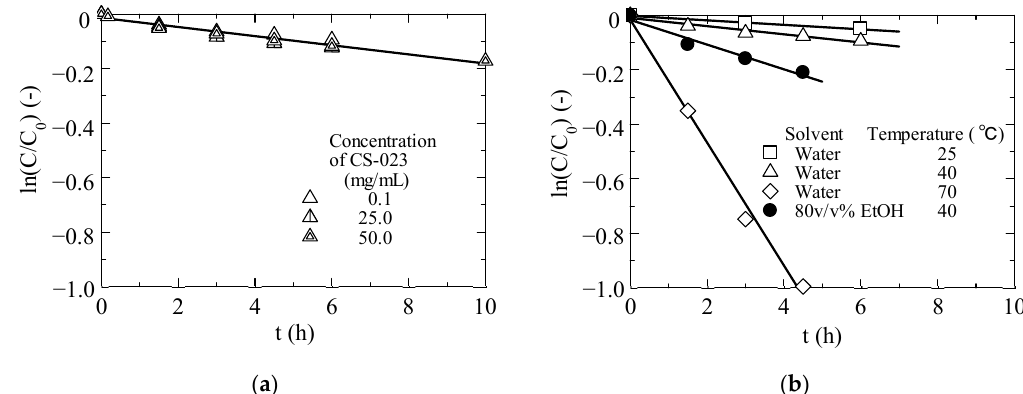
Figure 8. Stability of CS-023 in aqueous solution and 80 v/v % ethanol solution: ( a ) Dependence on initial concentration of CS-023, ( b ) Dependence on temperature.